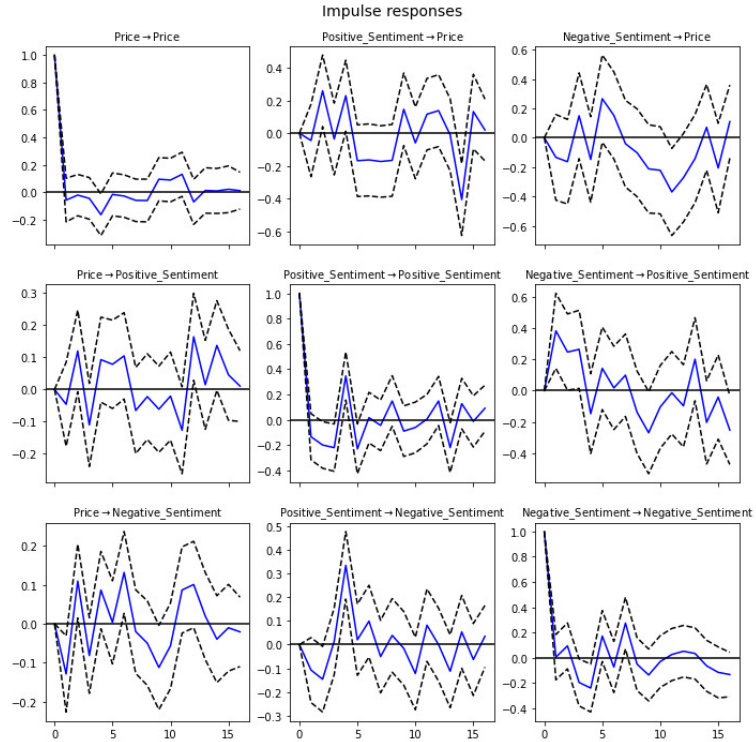
Figure A1. The impulse response function plots from the